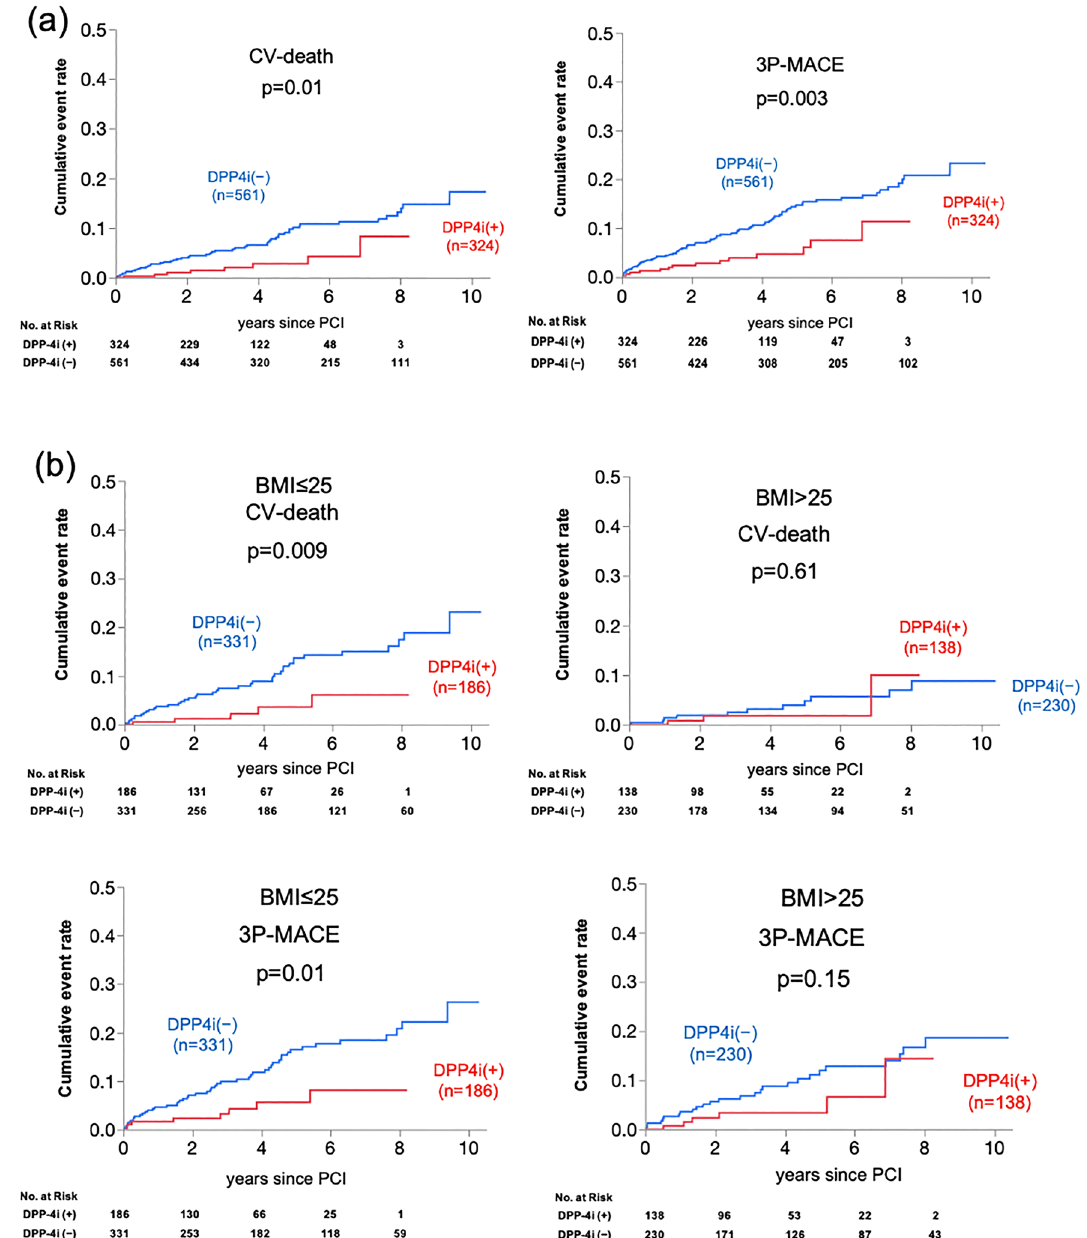
Figure 1. Cumulative incidences of adverse cardiovascular events following PCI in patients with and without DPP4i. ( a ) Cumulative incidences of CV death and 3P-MACE in patients treated with and without DPP4i (DPP4i (+) and (−) groups). ( b ) Cumulative incidences of CV death and 3P-MACE in DPP4i (+) and (−) groups in patients with and without low BMI (≤ and > median BMI, 25). CV cardiovascular, 3P-MACE 3-point